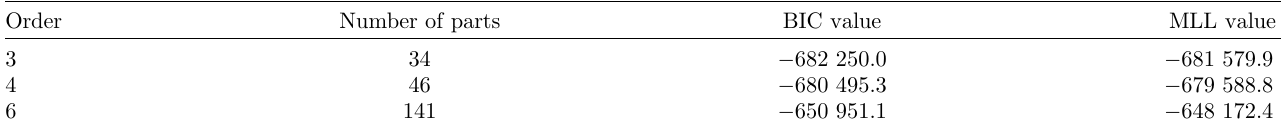
Table 5. For each order o = 3, 4, 6 records of (a) number of estimated parts, (b) value of the BIC – see equation (2), (c) fi rst term of the BIC (term of